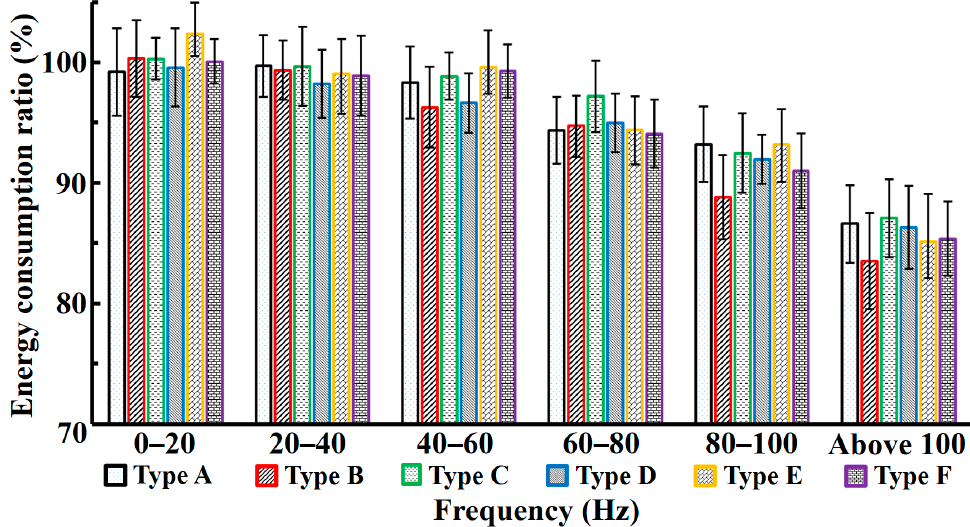
Figure 13. The ratio of forced vibration subsoiling total energy consumption to non-vibration energy consumption at 3 km/h speed.